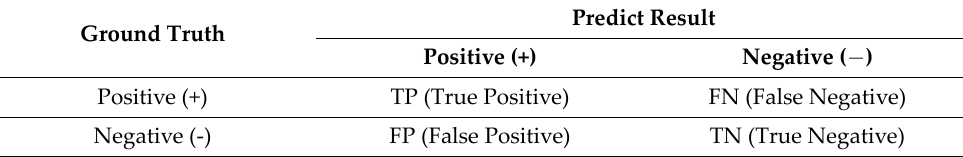
Table 4. Precision Recall.